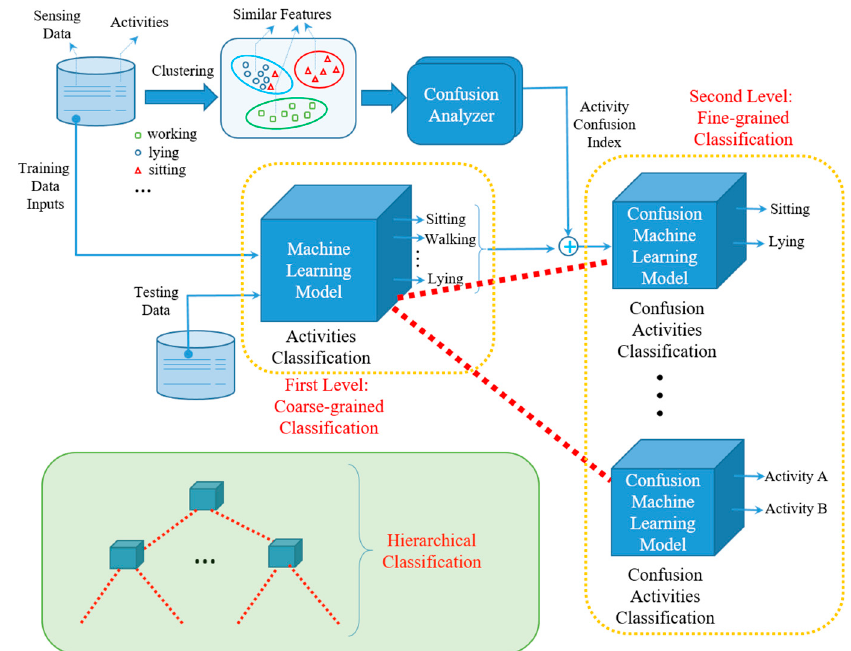
Figure 1. The Flowchart of the proposed model.